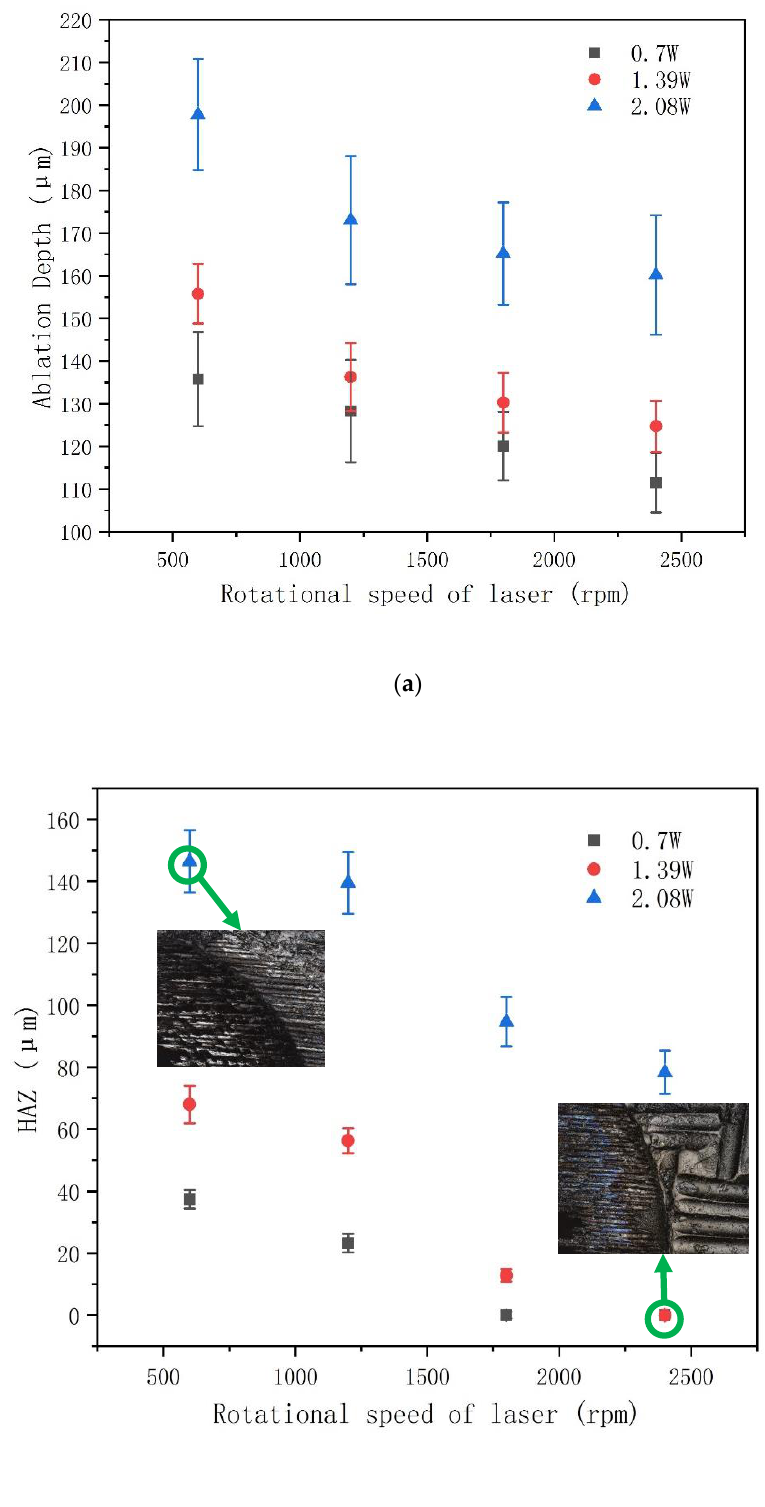
Figure 4. Effect of power/rotational speed on ( a ) ablation depth and ( b ) HAZ using spiral laser drilling. Repetition rate: 50 KHz; powers: 0.7 W, 1.39 W, and 2.08 W; number of passes: 25 passes; diameter: φ 67 8 um; rotational speed of laser: 600 rpm, 1200 rpm, 1800 rpm, 2400 rpm.